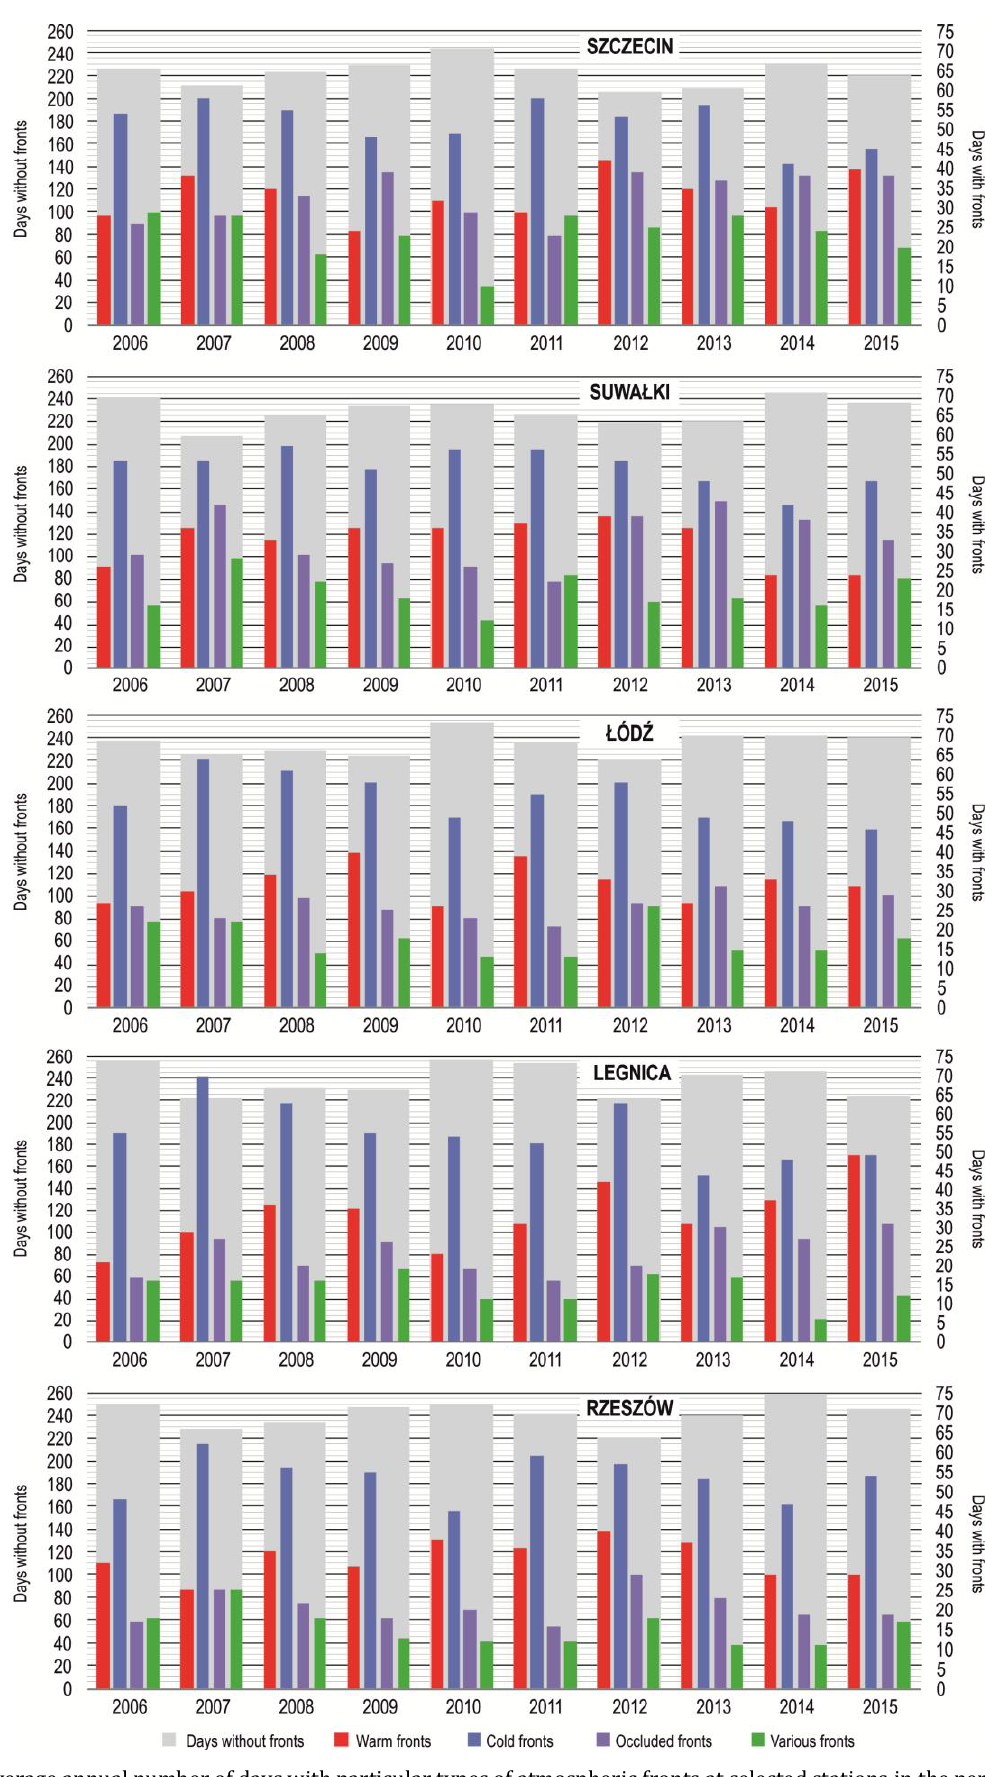
Fig. 4. Average annual number of days with particular types of atmospheric fronts at selected stations in the period